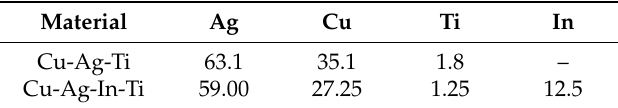
Table 1. Compositions in atomic percent of the braze alloys.